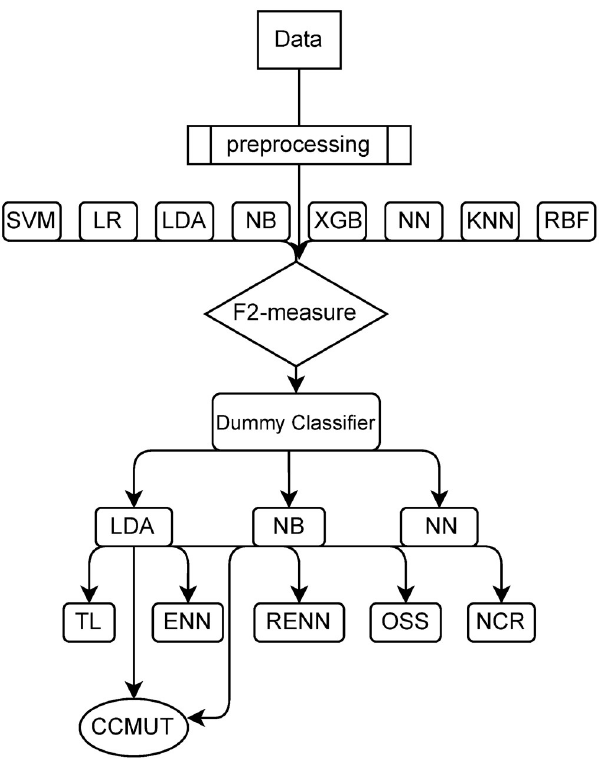
Fig 2. Experimental procedure. Complete experimental flow